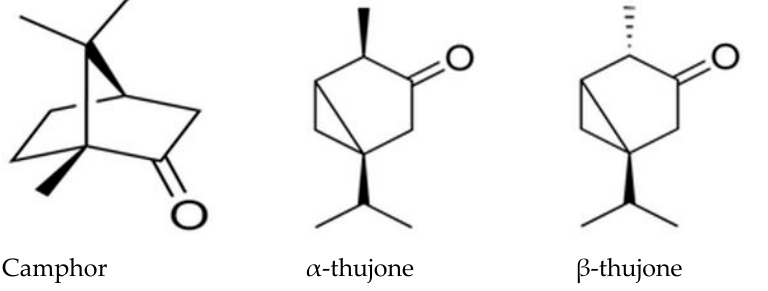
Figure 8. Structures of the main components in sage oil.